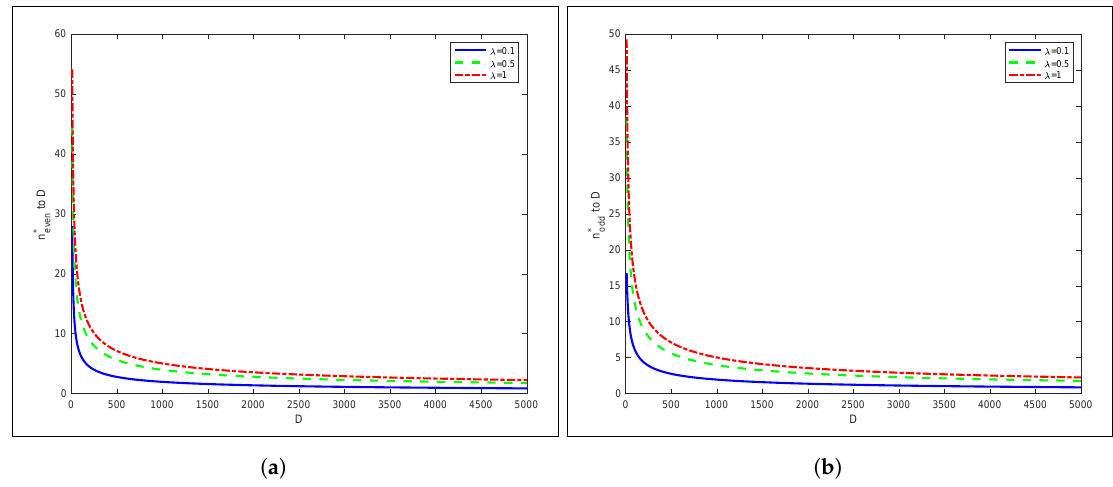
Figure 6. Percentage of n ∗ as a function of the total video size D for n ∗ even and odd, respectively. ( a ) n ∗ even; ( b ) n ∗